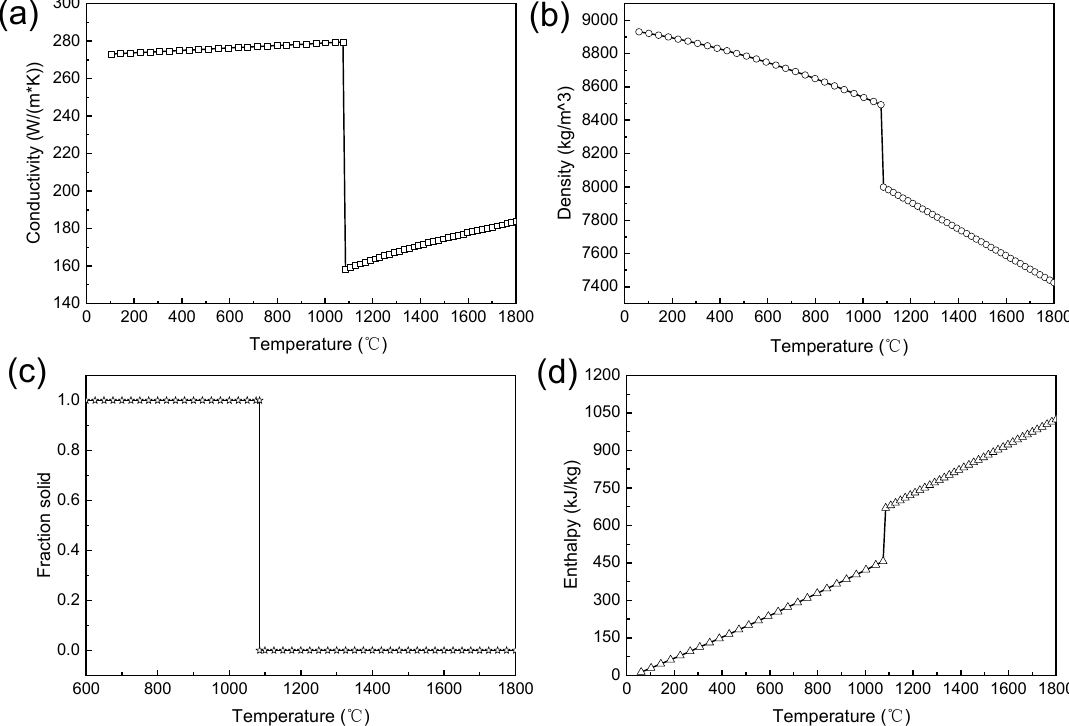
Figure 1. Material properties used in this study, including conductivity ( a ), density ( b ), fraction solid ( c ), and enthalpy ( d ).